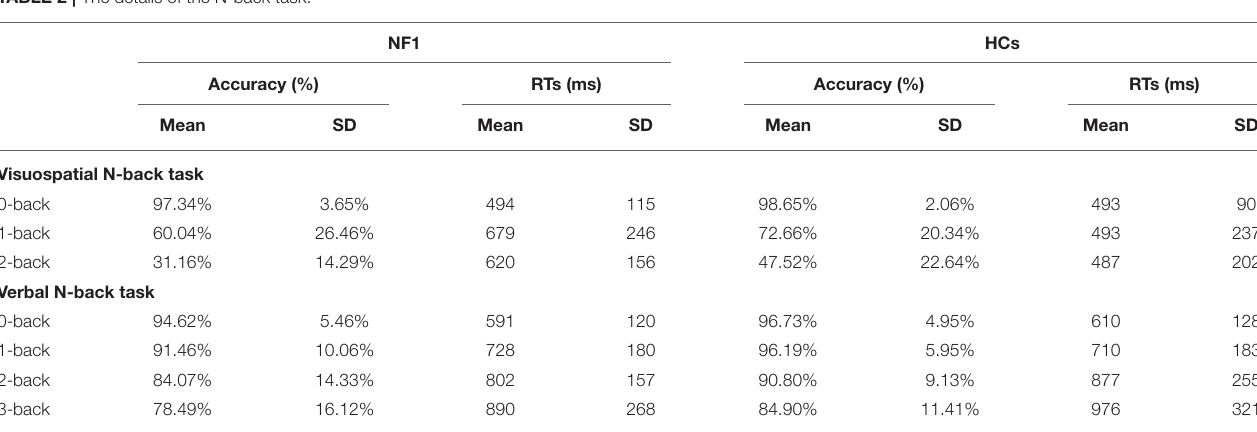
TABLE 2 | The details of the N-back task.